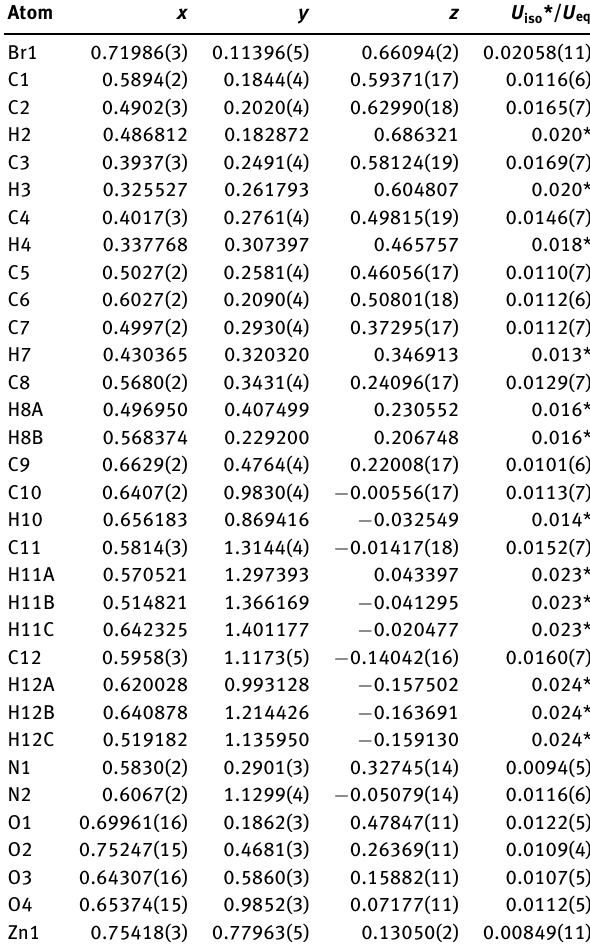
Table 2: Fractional atomic coordinates and isotropic or equivalent isotropic displacement parameters (Å 2